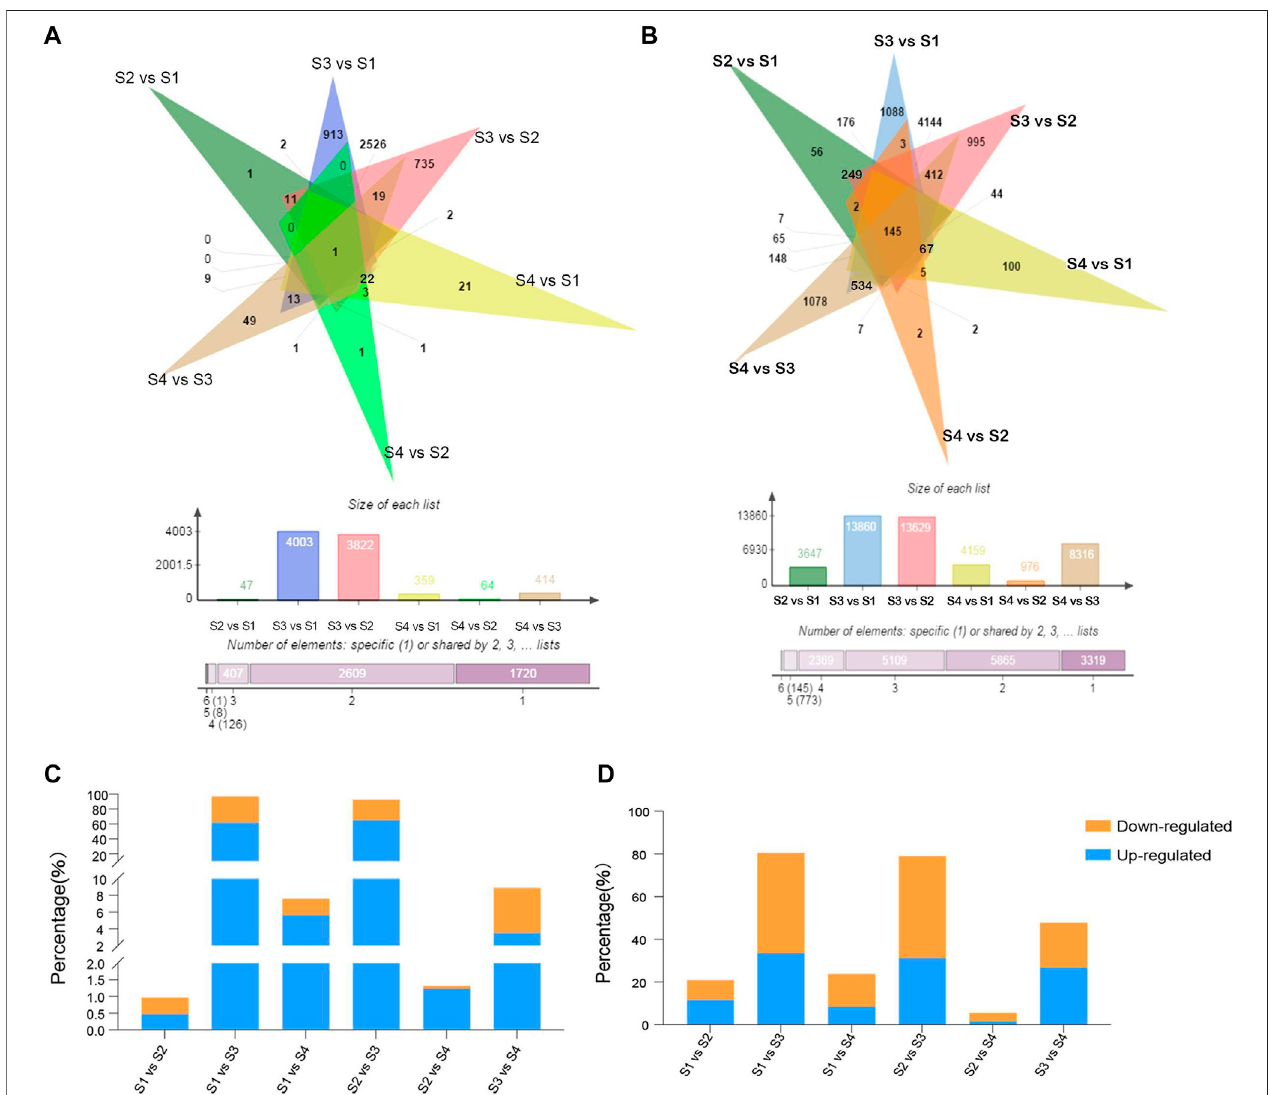
FIGURE 2 | Analysis and identi fi cation of differentially expressed lncRNAs (DELs). (A) Venn diagram of common and speci fi c DELs. (B) Venn diagram of common and speci fi c differentially expressed mRNAs. (C,D) Percentages of DEGs and DELs.